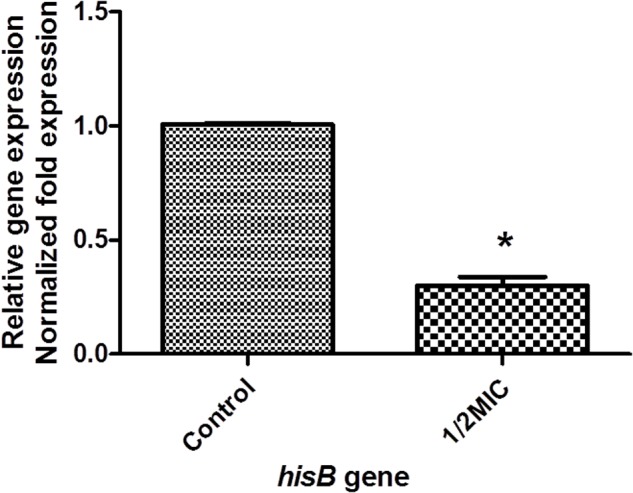
The mRNA expression of hisB gene in wild-type S. xylosus ATCC700404 strain with 1/2MIC of cefquinome and non-treated. Data are expressed as means ± SDs. The expression was normalized to 16SrRNA. Controls refer to the absence of cefquinome. Significantly different (∗p < 0.05) compared to untreated control bacteria.